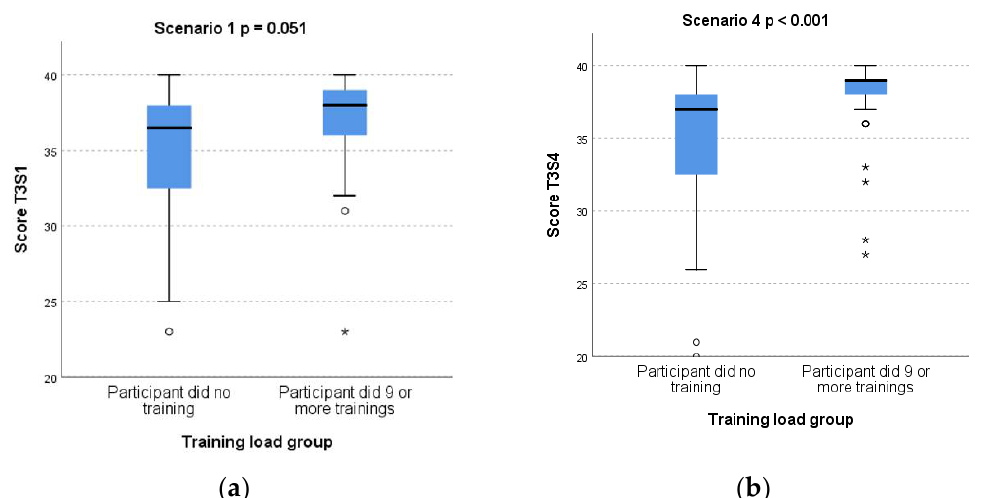
Figure 4. Box plots of test T3 scores for scenario S1 ( a ) and scenario S4 ( b ) according to training-load group.